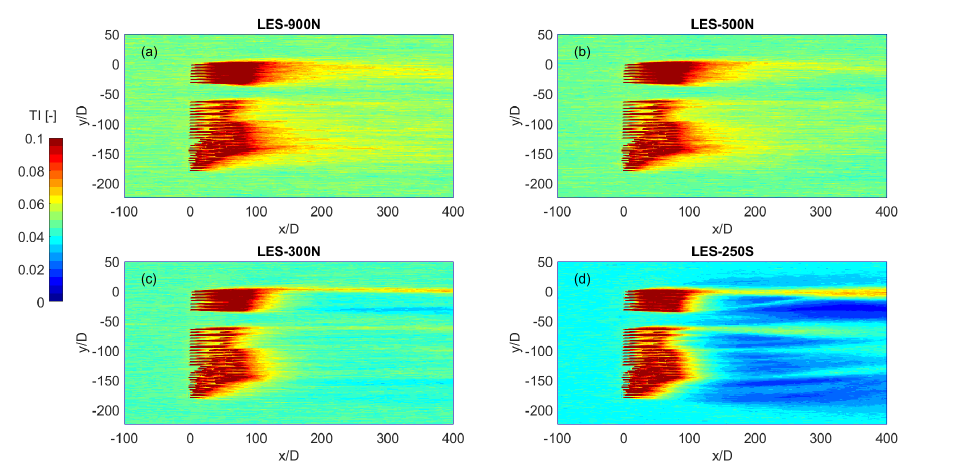
Figure 4. Horizontal cross-sections at hub height of the large-eddy-simulated streamwise turbu- lence intensity TI for neutral (LES-900N ( a ), LES-500N ( b ), LES-300N ( c )) and stable (LES-250S ( d )) conditions colored according to the colorbar at